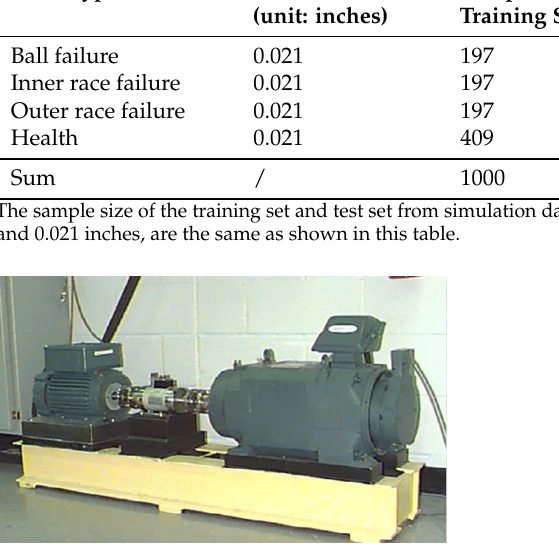
Figure 7. Experimental